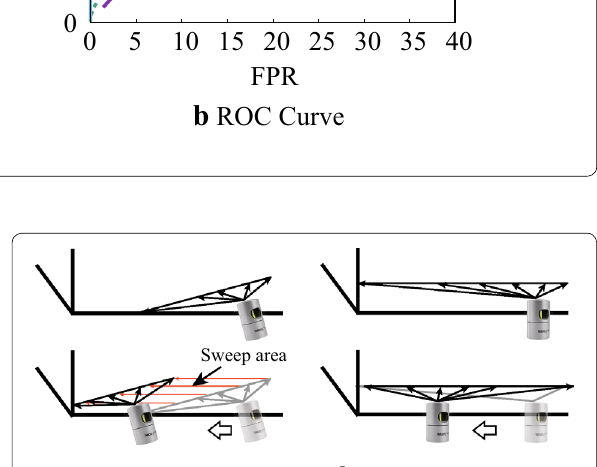
b Laser scanner is not tilted. a Laser scanner is tilted.